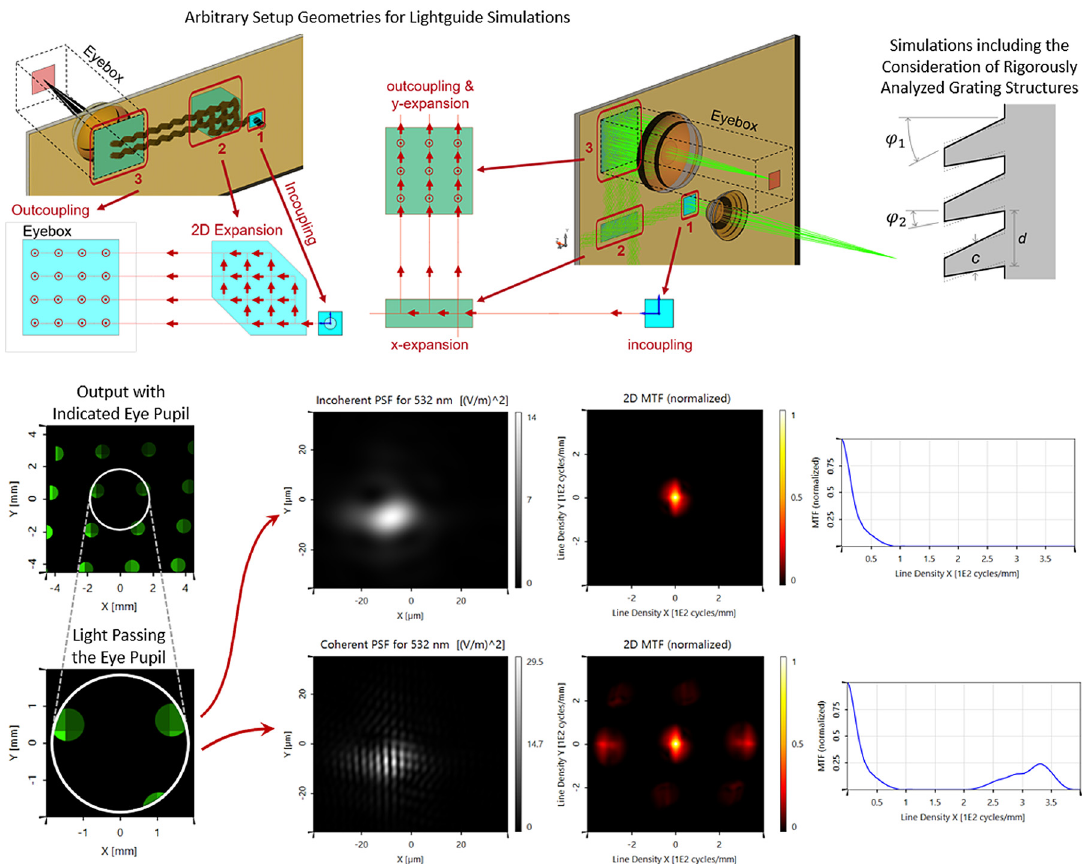
Figure 17: Waveguide grating combiner modeling by LightTrans (Germany) in 2D EPE version.